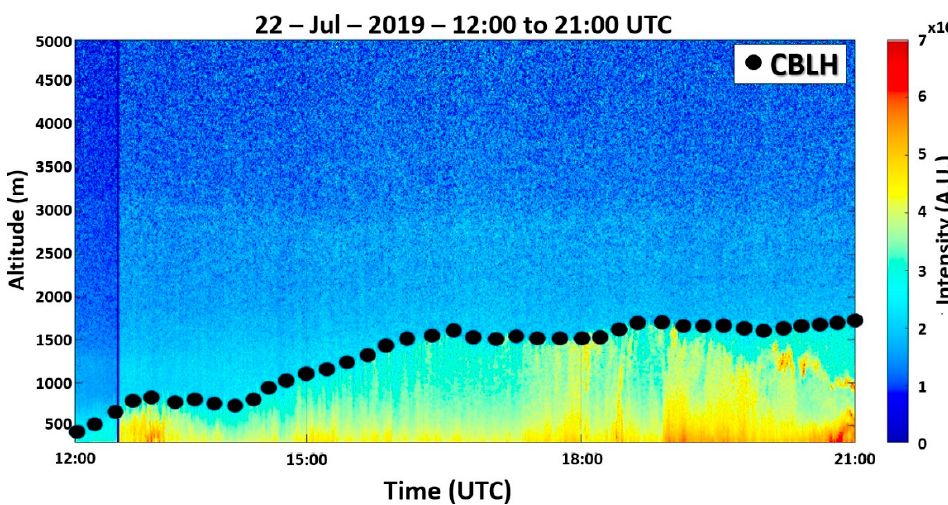
Figure 2. Range corrected signal (RCS 532 ) profiles from 12:00 UTC to 21:00 UTC on 22 July 2019. The black dots represent the CBLH. The color bar represents the intensity of the RCS 532